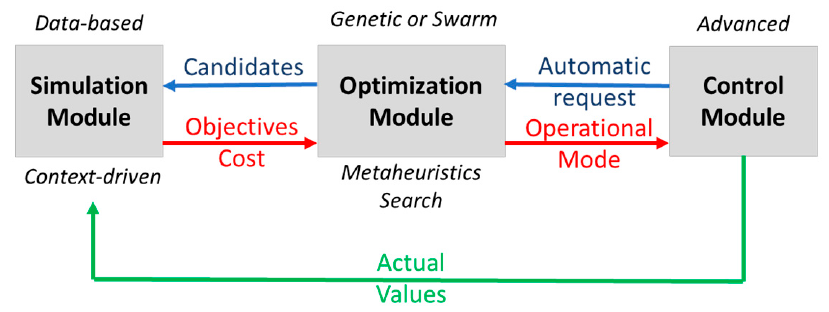
Figure 5. Advanced control optimized with a predicting context-driven model.